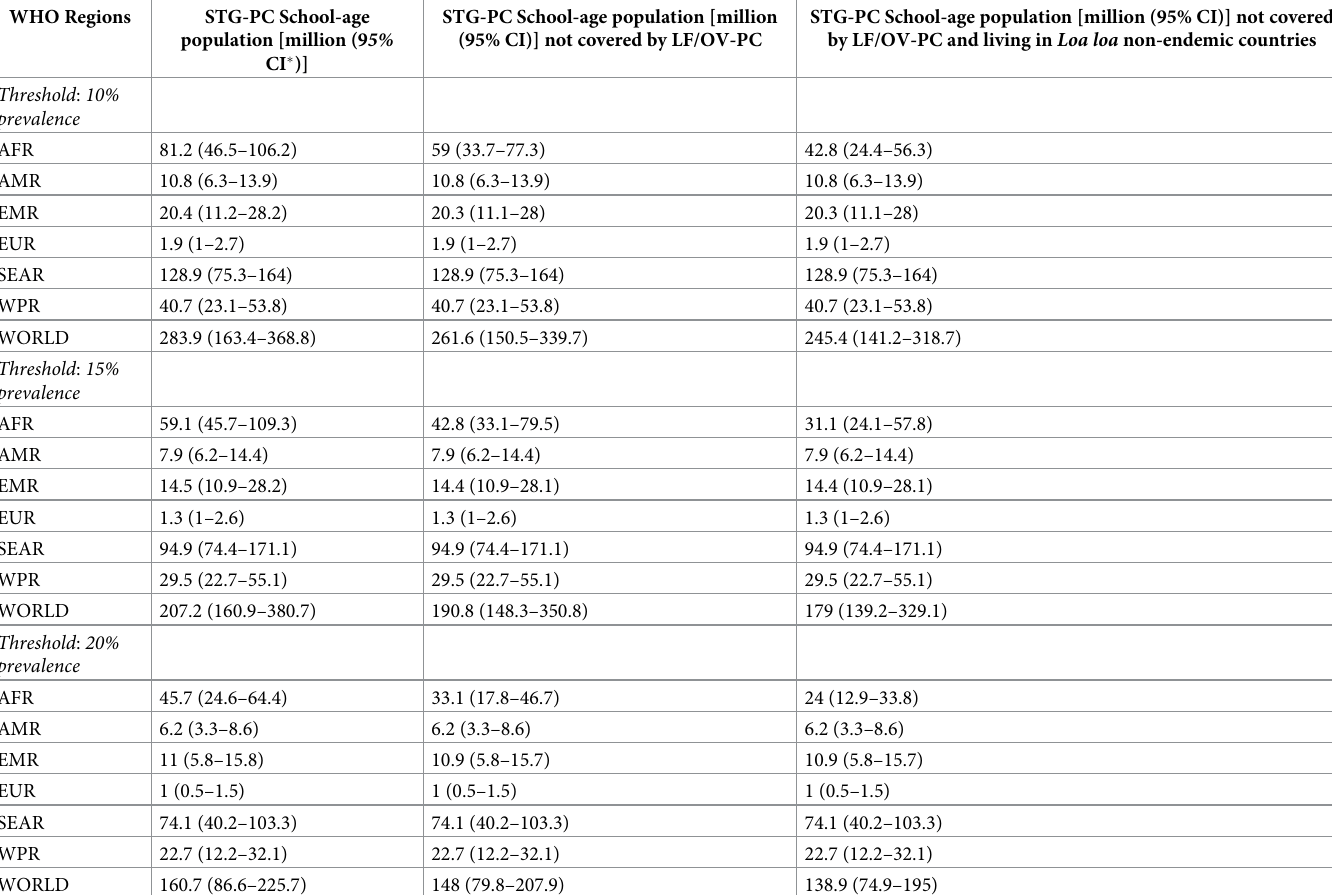
Table 1. Global and regional number of SAC who live in areas with strongyloidiasis prevalence above PC intervention thresholds. The table contains estimates made by taking into account LF/OV intervention and Loa loa endemicity. WHO